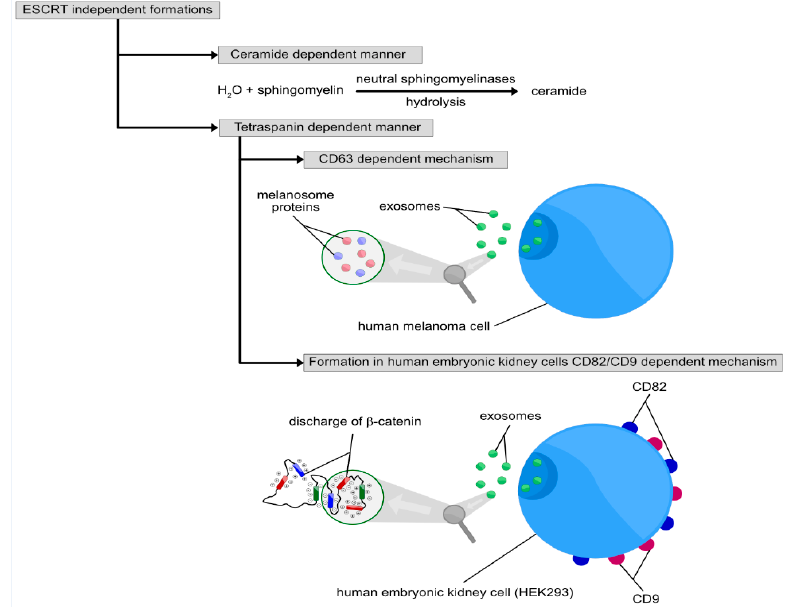
Figure 4. Three independent of each other processes of ESCRT-independent formation are proferred, including ceramide dependent manner, cluster of differentiation 63 (CD-63) dependent mechanism and ESCRT-independent formation in human embryonic kidney cells (HEK293). The ceramide dependent manner of ESCRT-independent formation relies on hydrolysis of spingomyelin to ceramide associated by the presence of neutral sphingomyelinases (nsMase). CD-63 dependent mechanism of ESCRT-independent mechanism is associated with release of exosomal cargo containing melanosome proteins from the exosomes secreted by human melanoma cells. ESCRT independent exosomal nanovesicle formation in HEK293 relies on discharge of β -catenin through the membrane of exosomes secreted by CD82 + CD9 + HEK293